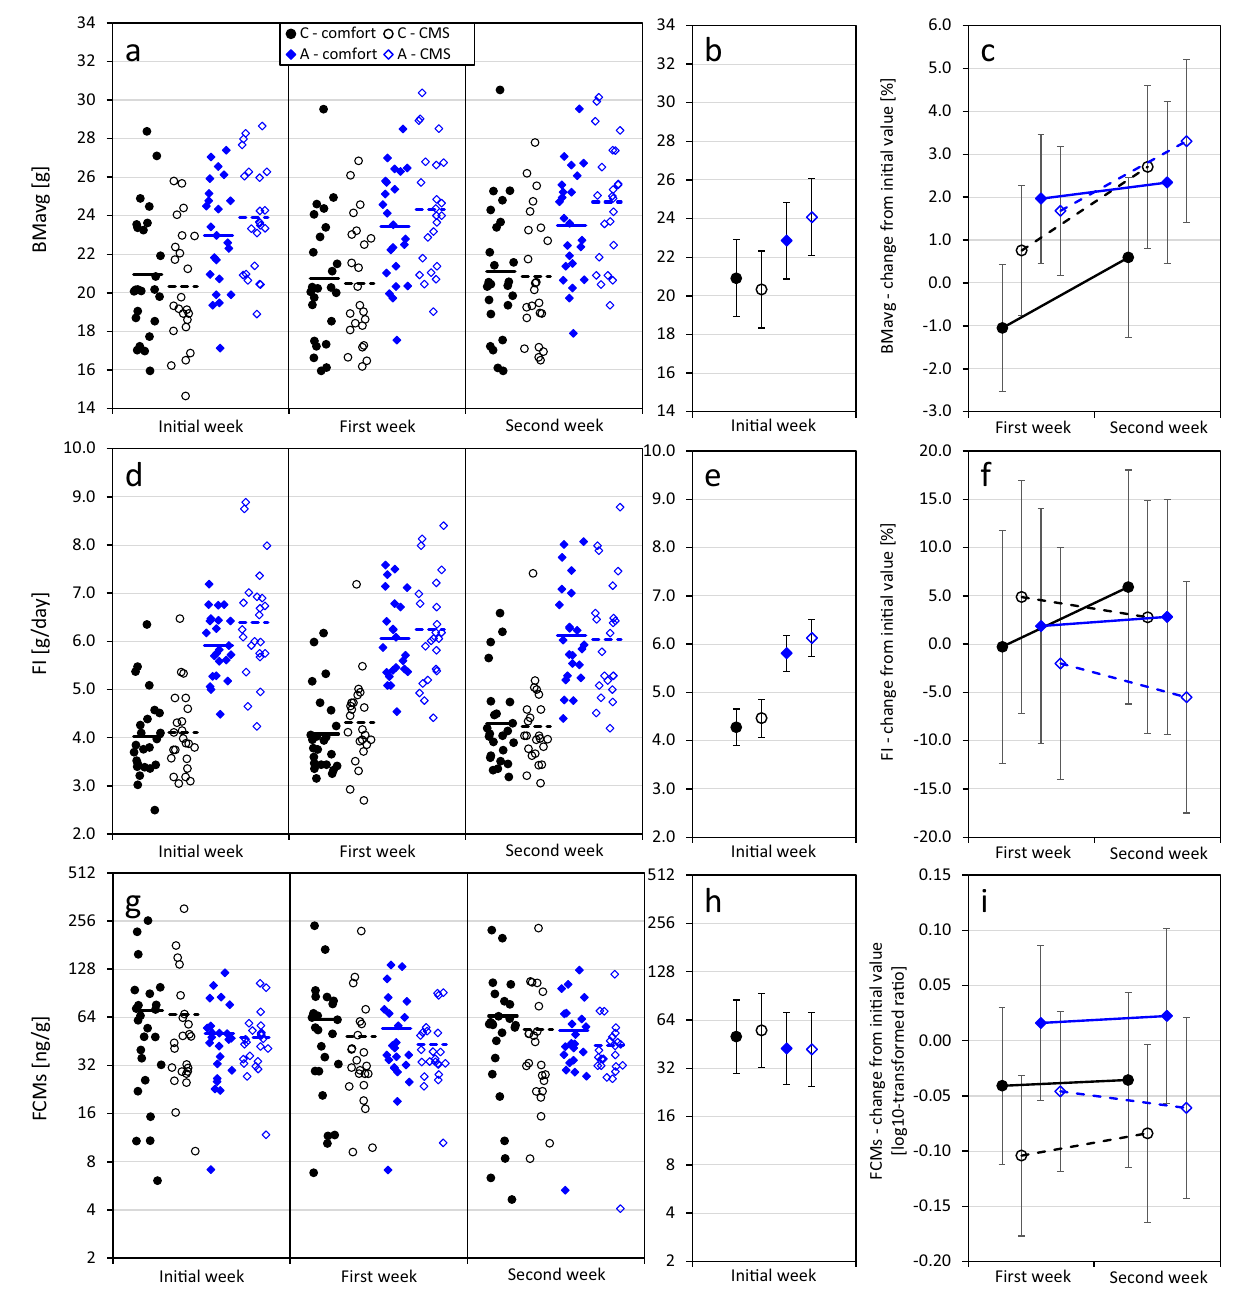
Figure 3. The effects of selection and chronic mild stress (CMS) on bank vole body mass (BMavg), food intake rate (FI), and fecal corticosterone metabolites level (FCMs) measured before (Initial week) and during (First and Second week) the experiment. The experiment was performed on 48 C-line (“control”) and 46 A-line (“aerobic”) voles. Left column – raw data with group means, middle and right columns—least squares means ± 95% confidence intervals, for FI and FCMs calculated for an average (22.4 g) body mass. Results of the experimental treatment (right column) for BMavg and FI are represented by % change, and for FCMs as the log 10 -transformed ratio, relative to the initial CMS group, but not in the comfort group (effect of selection tested within groups: CMS: p = 0.016, comfort: p = 0.15, selection × treatment interaction: p = 0.046, Fig. 3b). Apparent food intake rate (FI), averaged across 6 days preceding the treatment, ranged from 2.5 to 8.9 g/ day, and was higher in heavier animals (effect of BMavg: p < 0.0001, Table 3, Supplementary Table S2, Fig. 3d). Mass-adjusted FI did not differ between sexes ( p = 0.7), but was significantly higher in the A than in C lines (A lines: 6.16 ± 0.97 g/day, C lines: 4.06 ± 0.85 g/day, p < 0.0001). The FI did not differ between animals assigned to the two CMS treatment groups ( p = 0.16, Fig. 3e).